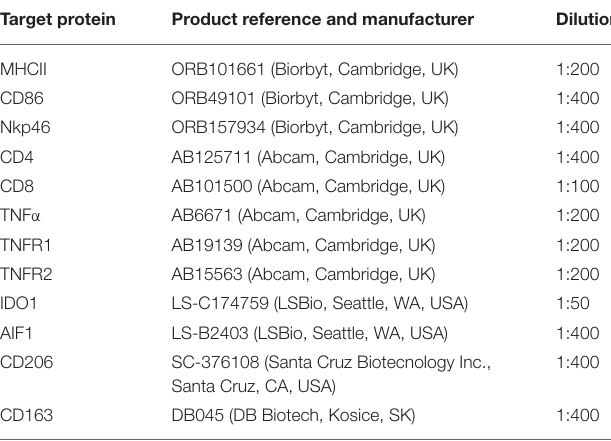
TABLE 3 | Surface markers selected for identification of macrophage and lymphocyte subsets. Macrophage